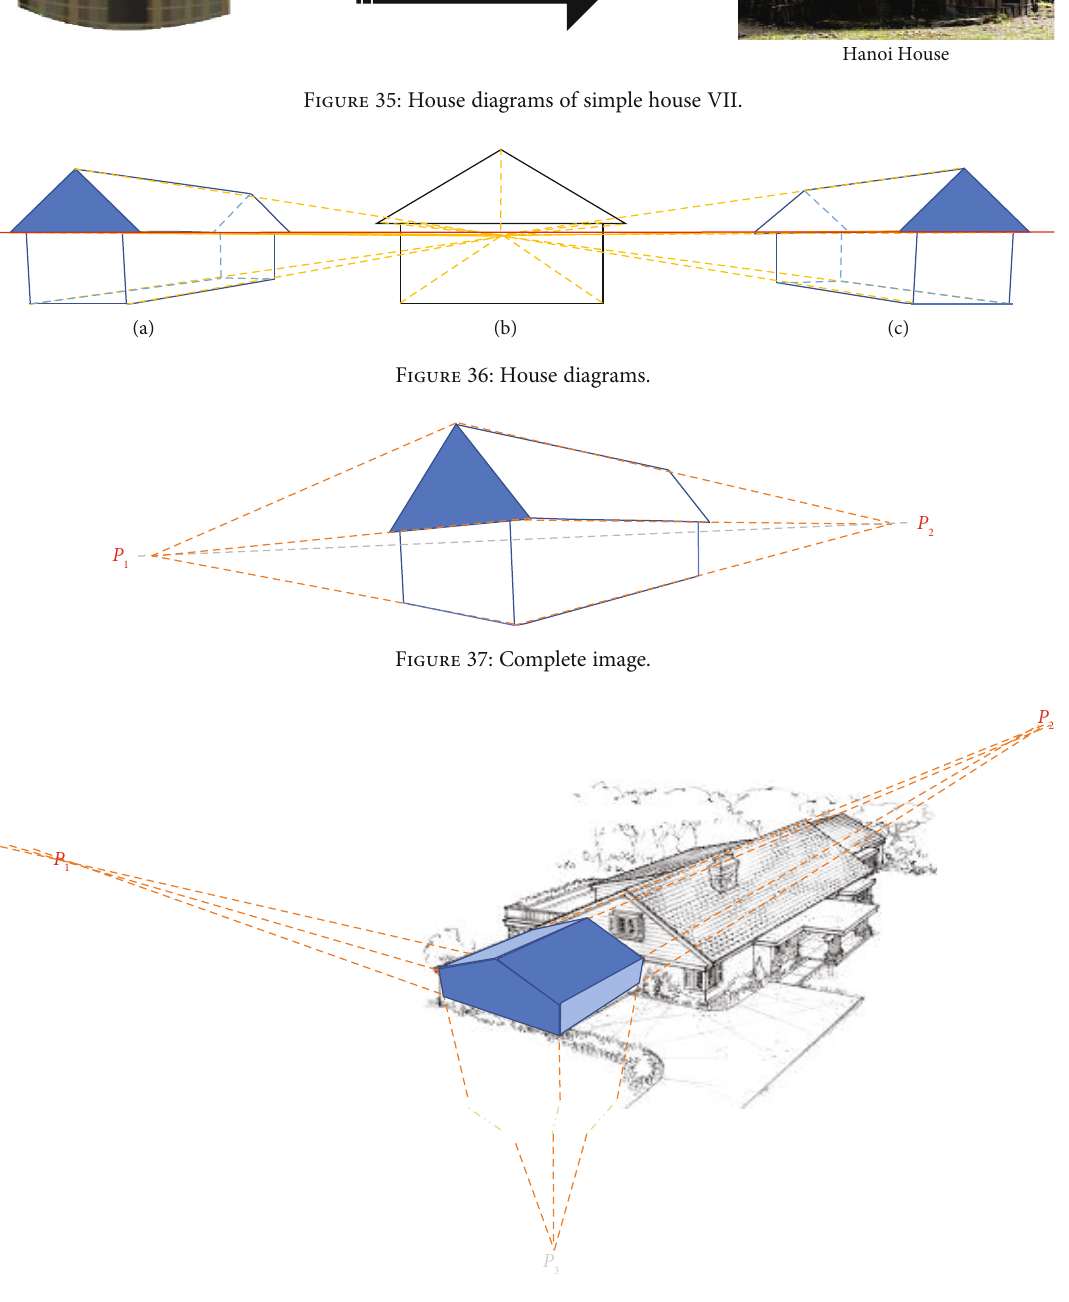
Figure 38: Complete